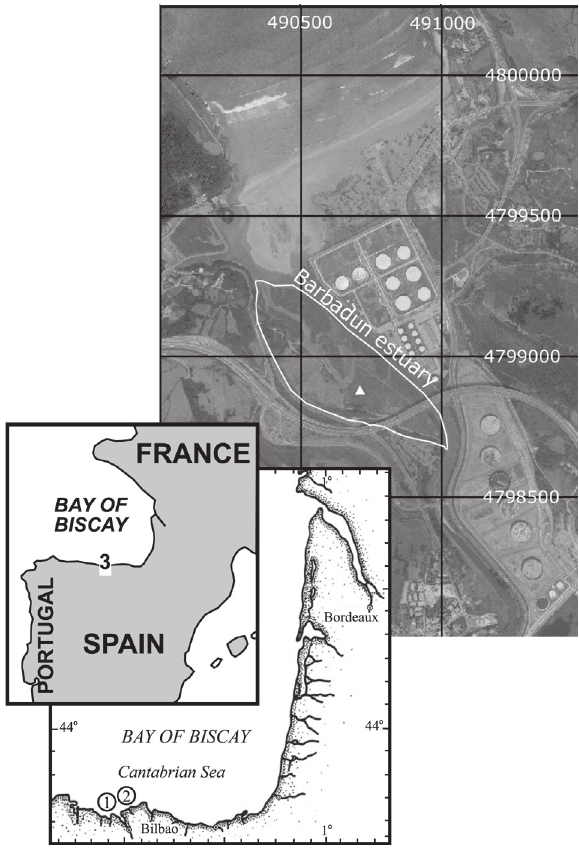
Fig . 1. – Location of the muskiz marsh (highlighted by the white border) in the Barbadun estuary and localities referred to in the